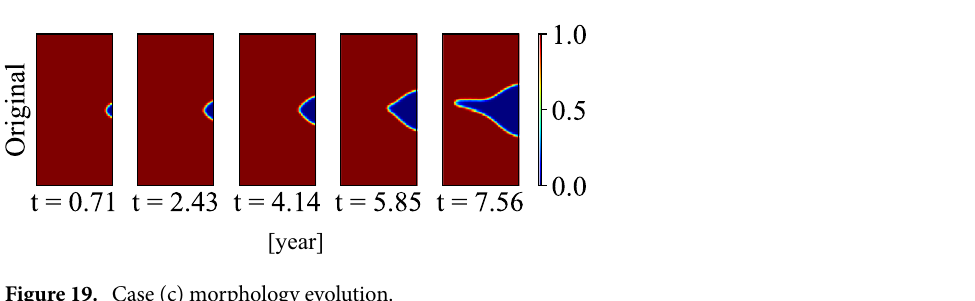
Figure 19. Case (c) morphology